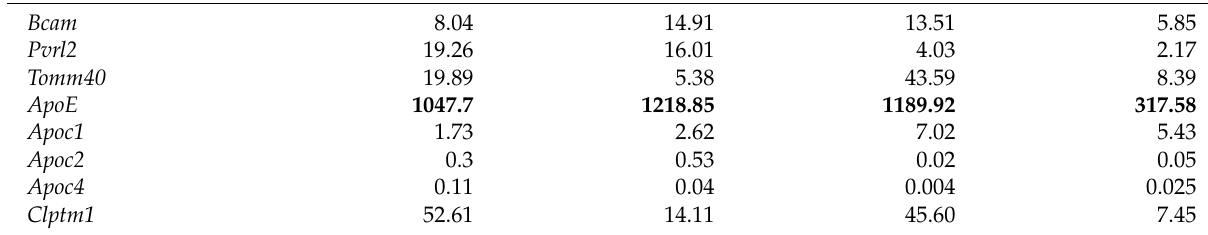
Table 4: Correlation coefficients between genes of ApoE region in our data based on 45 samples. Variables